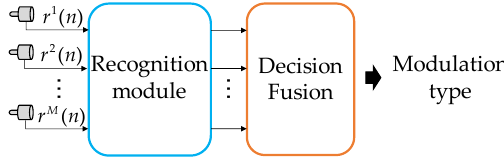
Figure 5. Structure of the decision fusion method.